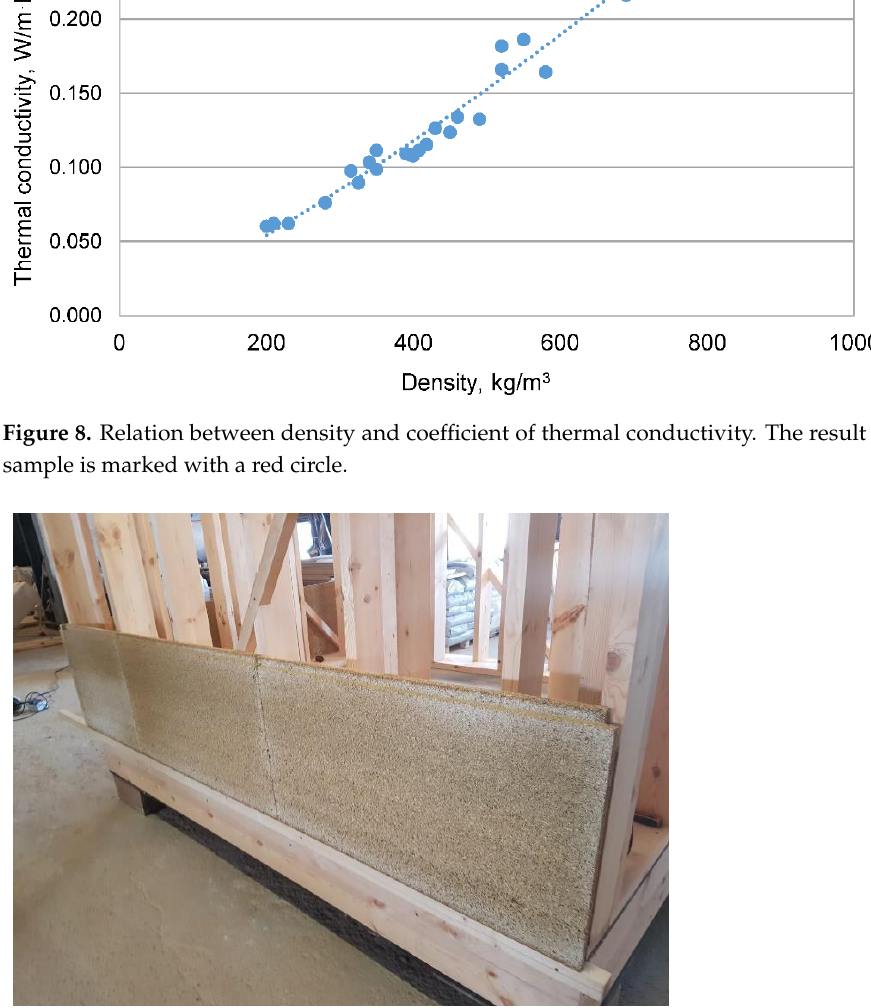
Figure 9. MOC biocomposite boards during construction of timber frame testing